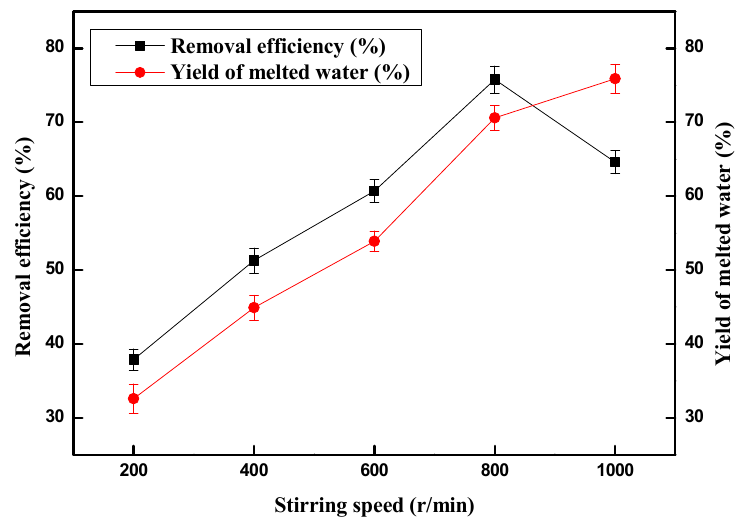
Figure 5. Effect of stirring speed on the removal of copper (II) ions and the yield of melted water.